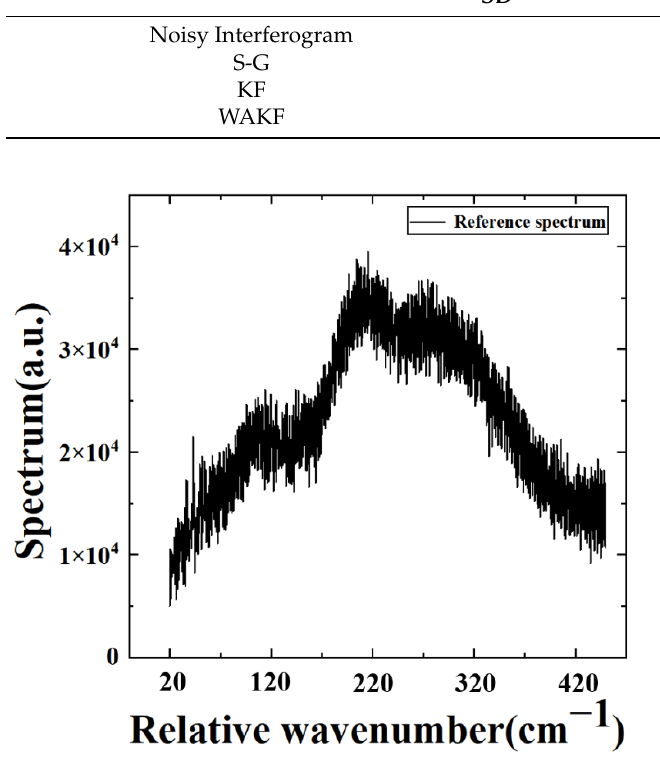
Figure 7. The reference spectrum of the 747th pixel at a sampling frequency of 80 MHz.